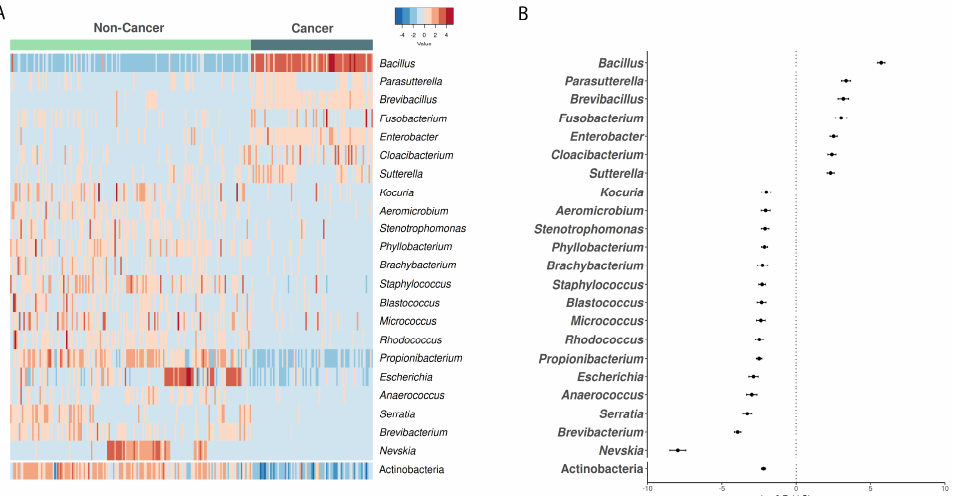
Figure 1. Microbiota composition in gastric cancer and non-cancerous samples. ( A ) Heatmap of statistically significant di ff erentiated genera and phyla abundance when comparing the control Genotype-Tissue Expression (GTEx) non-cancer gastric microbiome with the European ancestry (Europe and USA) The Cancer Genome Atlas (TCGA) cancer samples. ( B ) Log2 fold change of the statistically significant di ff erentiated genera and phyla between the non-cancer (negative axis) and cancer (positive axis) cohorts.